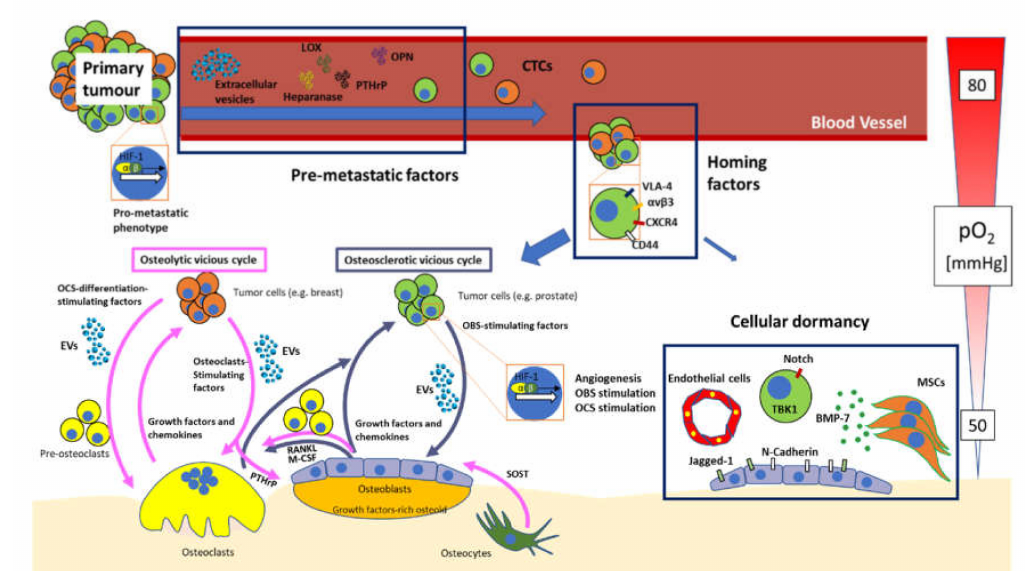
Figure 1. Overview of the bone metastatisation process. The primary tumour gets access to the circulation, also thanks to the activation of the HIF pathway, which activates a pro-metastatic program in a subset of cancer cells. Before metastases take place, a number of premetastatic factors, including extracellular vesicles, lysyl oxidase (LOX), heparanase, parathyroid hormone-related peptide (PTHrP), and osteopontin (OPN) educate the bone microenvironment making it suitable for metastatic engraftment. Circulating tumour cells (CTCs) can then extravasate and engraft in the bone thanks to homing factors such as very late antigen (VLA)-4 and α v β 3 integrins, C-X-C chemokine receptor type (CXCR)-4 and CD44. Once in the bone microenvironment, most cells entertain a cross-communication with bone cells, changing the physiologic “virtuous cycle” between osteoblasts and osteoclasts into a “vicious cycle” that favours tumour growth. Two types of vicious cycles are known. The osteosclerotic vicious cycle, normally established by prostate cancer cells, exploits osteoblasts (OBS)-stimulating factors (including extracellular vesicles) to increase OBS production of growth factors, as well as receptor activator of nuclear factor kappa B ligand (RANKL) and macrophage-colony-stimulating factor (M-CSF), that, in turn, stimulate osteoclast di ff erentiation, further allowing the release of growth factors from the bone matrix. The growth factors produced by OBS and released by OCS then signal back to cancer cells, increasing their growth, thus closing the vicious cycle. The osteolytic vicious cycle is established by many types of tumours, including breast cancer. In this cycle, tumour cells use osteoclast-stimulating factors (including extracellular vesicles) and osteoclast di ff erentiation-stimulating factors (including extracellular vesicles) to increase bone resorption, leading to the release of growth factors from the bone matrix, thus furthering tumour growth and restarting the vicious cycle. PTHrP is also exploited by breast cancer cells to induce osteoclastogenesis indirectly, through osteoblastic RANKL and M-CSF. Osteocytes may also take a part in the osteolytic vicious cycle, by suppressing OBS activity through secretion of sclerostin (SOST). A crucial factor in the vicious cycle is HIF, that is activated partially thanks to the low pO2 of the bone marrow microenvironment, and causing increased angiogenesis, OBS stimulation and OCS stimulation. A very small contingent of cells may undertake an alternative path and progress through cellular dormancy. This process requires the stimulation of many membrane and soluble factors, such as bone morphogenic protein (BMP)-7, that induces prostate cancer dormancy, or Jagged-1 which proposedly promotes dormancy through Notch-2 in breast cancer cells. Mesenchymal stromal cells (MSCs), endothelial cells and spindle-shaped N-cadherin-positive osteoblasts (SNOs) seem to be crucial in this process, but also other cell types may be taking part in this process